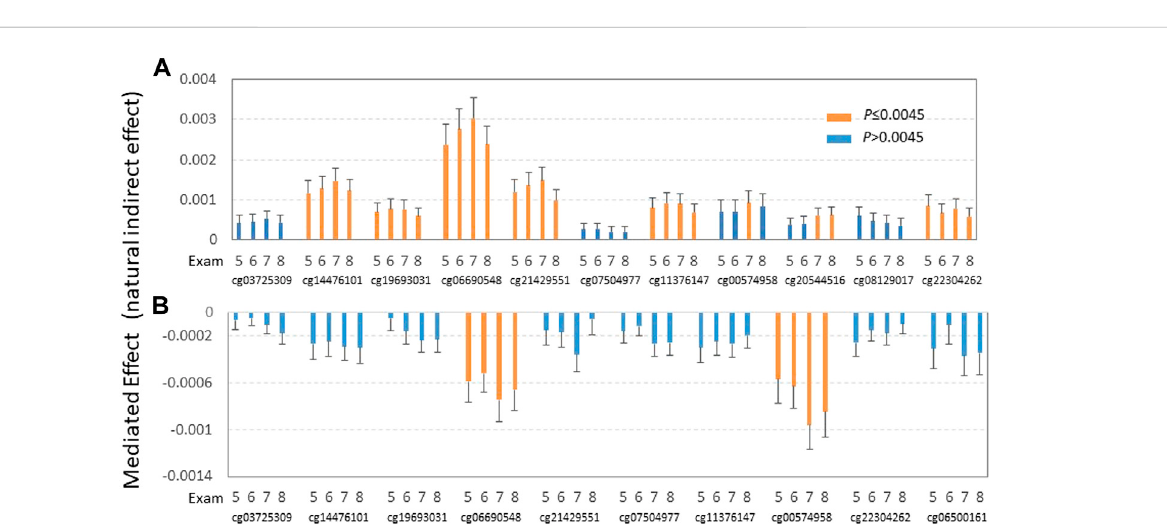
FIGURE 2 Effects ofalcoholconsumption (A) andcarbohydrate intake (B) on plasma TG via epigeneticmediators. Mediationanalysiswasconductedinall four examswhilecontrollingforsex,age,BMI,physicalactivity,smokingstatus,cell-typeheterogeneity,andmedicationsfortype2diabetesandhypertension at exam 8 (as DNA methylation was measured atexam 8). (A) Indirect effects of alcohol intake (% total energy) on TG through 11DMSs as mediators were estimated for four exams (exams 5 — 8) using mediation analysis in participants not taking lipid-lowering medication while controlling for covariates (sex, age BMI, physical activity, smoking status, cell-type heterogeneity, and medication for type 2 diabetes and hypertension at exam 8). (B) Indirect effects of carbohydrate intake (% total energy intake) on TG through 10 DMSs as mediators were estimated for four exams (exams 5 – 8) using mediation analysis in participants not taking lipid-lowering medication while controlling for covariates (sex, age, BMI, physical activity, smoking status, cell-type heterogeneity, and medication for type 2 diabetes and hypertension at exam 8). Orange and blue bars indicate signi fi cant and non-signi fi cant mediation effects of carbohydrate intake on TG after correction for multiple testing,